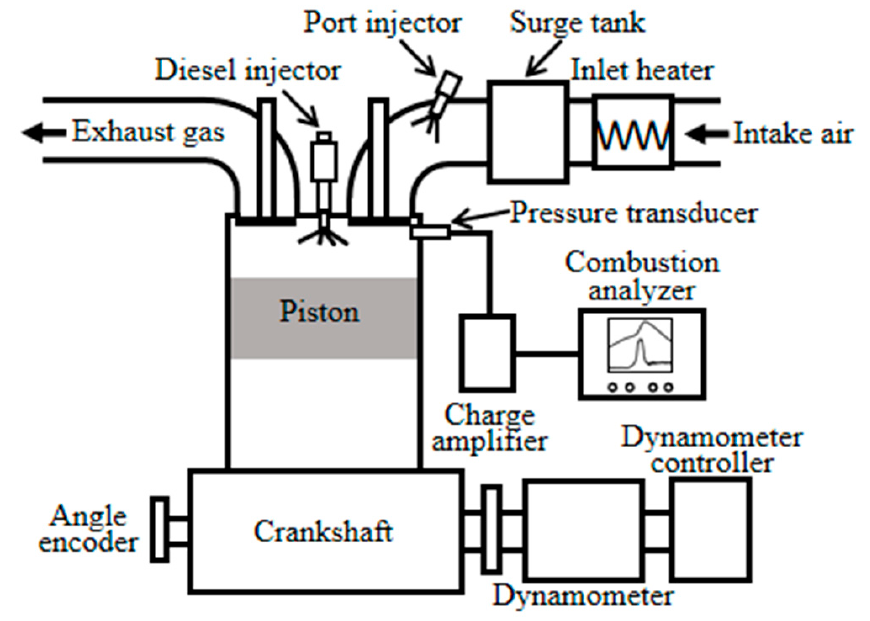
Figure 15. Schematic of the experimental setup. Table 2. Dual-fuel engine specifications and operating conditions.